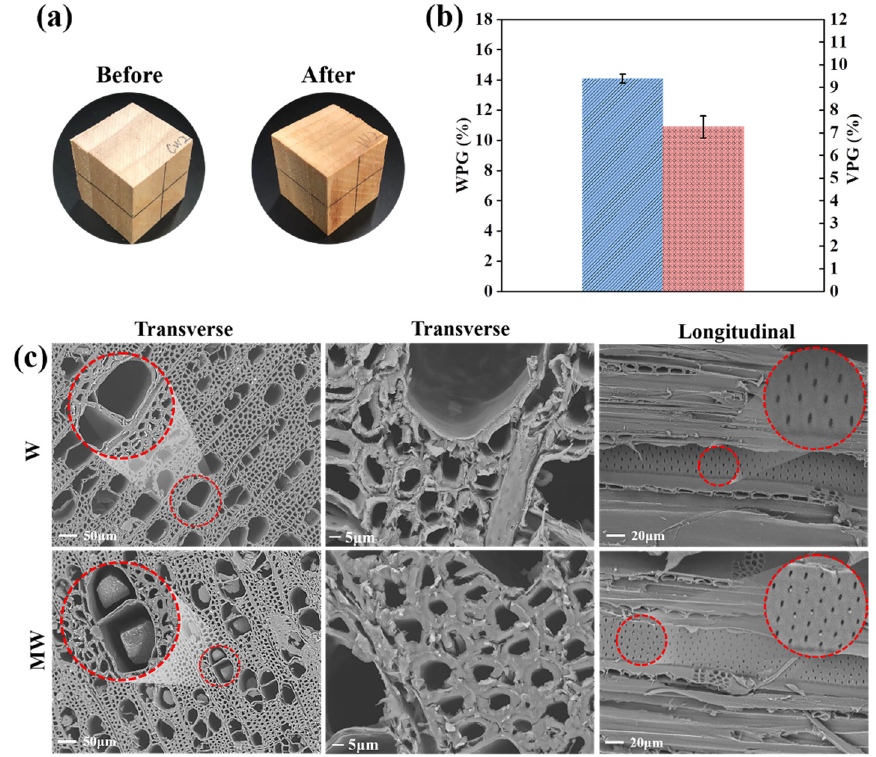
Figure 4. ( a ) Wood specimen before and after modification. ( b ) WPG and VPG of modified wood (MW). ( c ) SEM micrographs of untreated (W) and modified wood (MW).